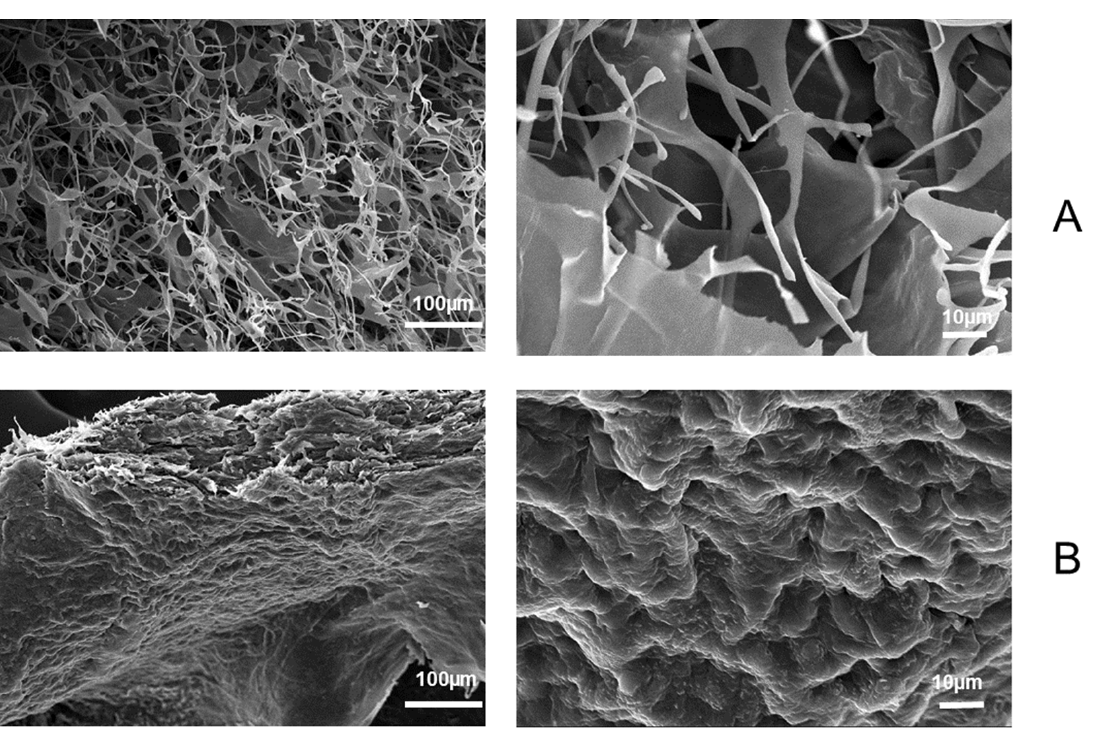
Figure 3. Scanning electron microscopies of ( A ): lyophilized empty SPECs; ( B ) orange essential oil loaded SPECs.